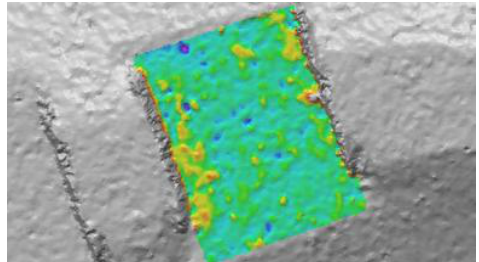
Figure 9. Differences between the adjusted planes (view from south-east)